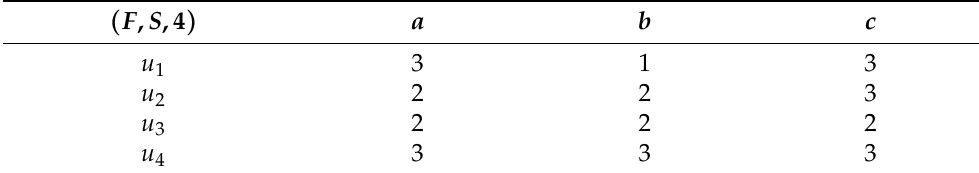
Table 9. Table 9. The 4-Soft Set of ( F , S ,4 ) . ( F , S , 4 ) a b